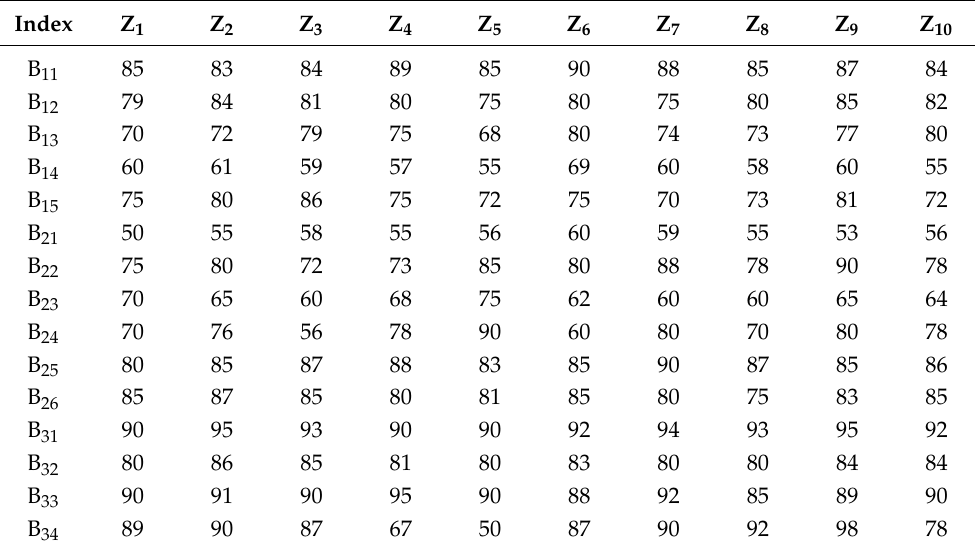
Table 4. University emergency management ability quantitative score